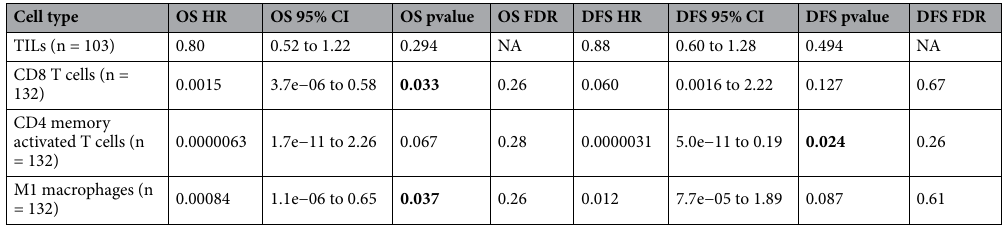
Table 2. Prognostic value of immune cell types in TCGA TNBC patients (univariate) (continuous). Bold : pvalue < 0.05. TCGA: The Cancer Genome Atlas; TNBC: triple negative breast cancer; TILs: tumor